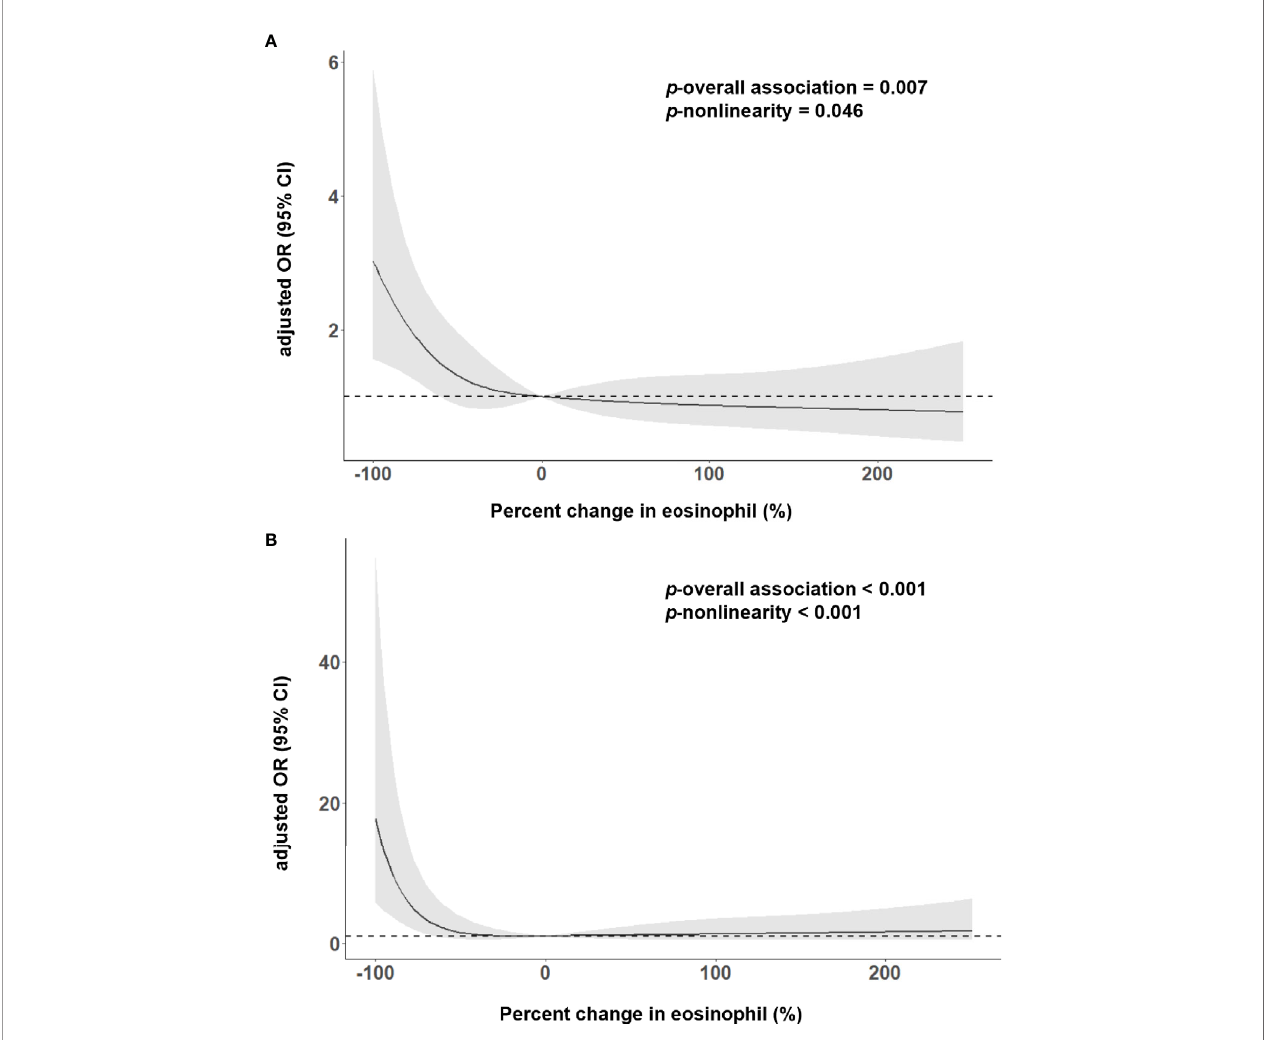
FIGURE 3 | Adjusted association of eosinophil changes after intravenous thrombolysis with (A) 3-month poor outcome; (B) death, using multiple spline regression analyses with four knots (at the fi fth, 35th, 65th, and 95th percentiles). The solid line indicates odds ratio, while the shadow indicates 95% CI. Reference point was 0. Data were adjusted for age, sex, current smoking, history of hypertension, atrial fi brillation, stroke, triglycerides and admission NIHSS